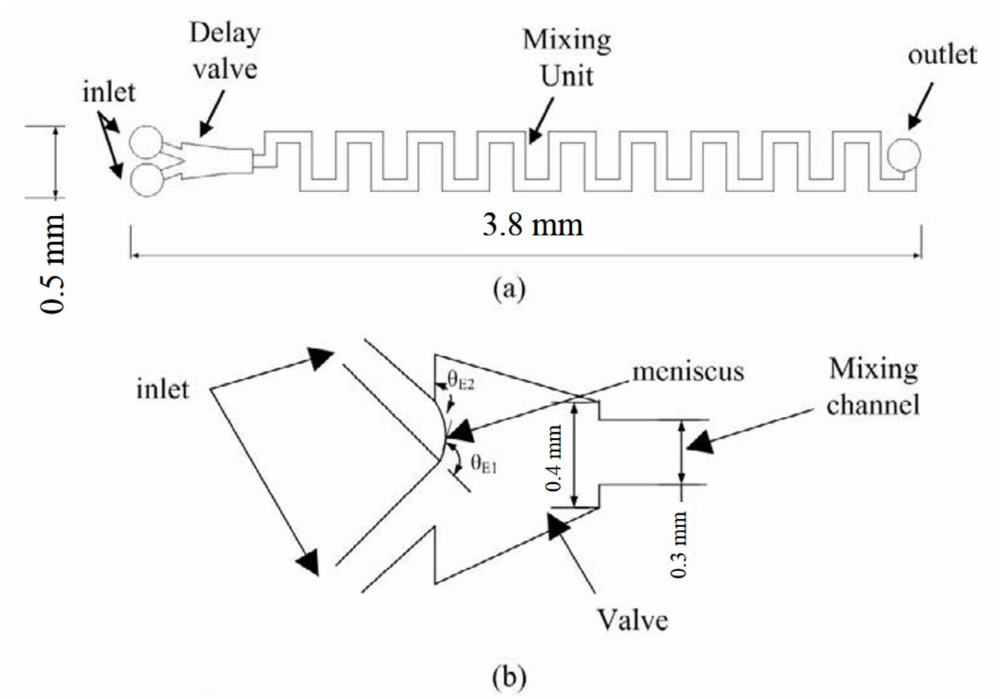
Figure 13. Schematic diagram of the designed: ( a ) Meander chip and ( b ) the triggering valve. The difference of capillary pressure in the triggering valve before and after the trig- gering effect is simulated by CFD-ACE software. The simulate results in both the closed and open-surface channels are shown in Figure 14. For the closed channel of 250 µ m before the triggering, the capillary pressure is approximately − 350 Pa (N m − 2 ) within the inlet channel to impede one fluid from advancing forward as shown in Figure